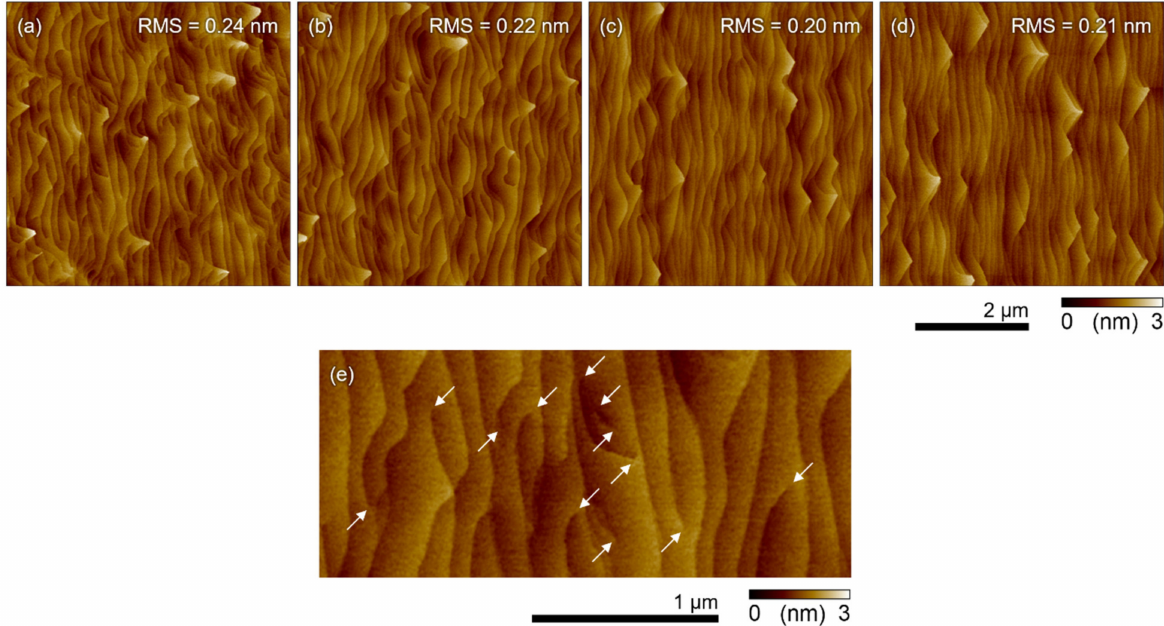
Figure 5. Atomic force microscopic (AFM) images of FFA Sp-AlN samples deposited using N 2 /(N 2 + Ar) ratios of: ( a ) 25%, ( b ) 50%, ( c ) 75%, and ( d ) 100%. The scale bar and height scale for ( a – d ) are uniform. ( e ) Magnified image of ( a ). The white arrows indicate step terminations that correspond to screw- or mixed-type